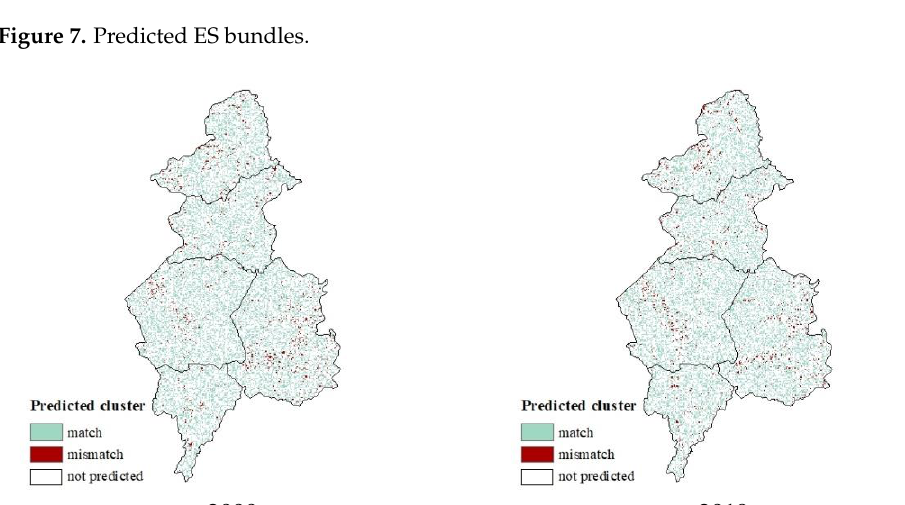
Figure 7. Predicted ES bundles.